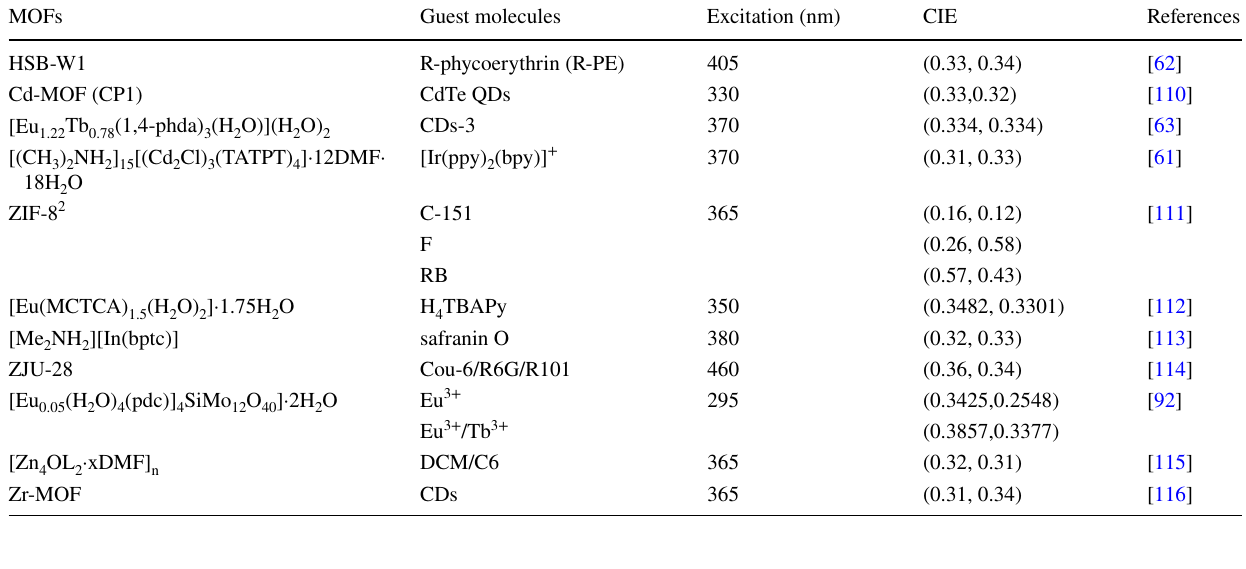
Table 4 Photoluminescent MOFs for white-light emission MOFs Guest molecules